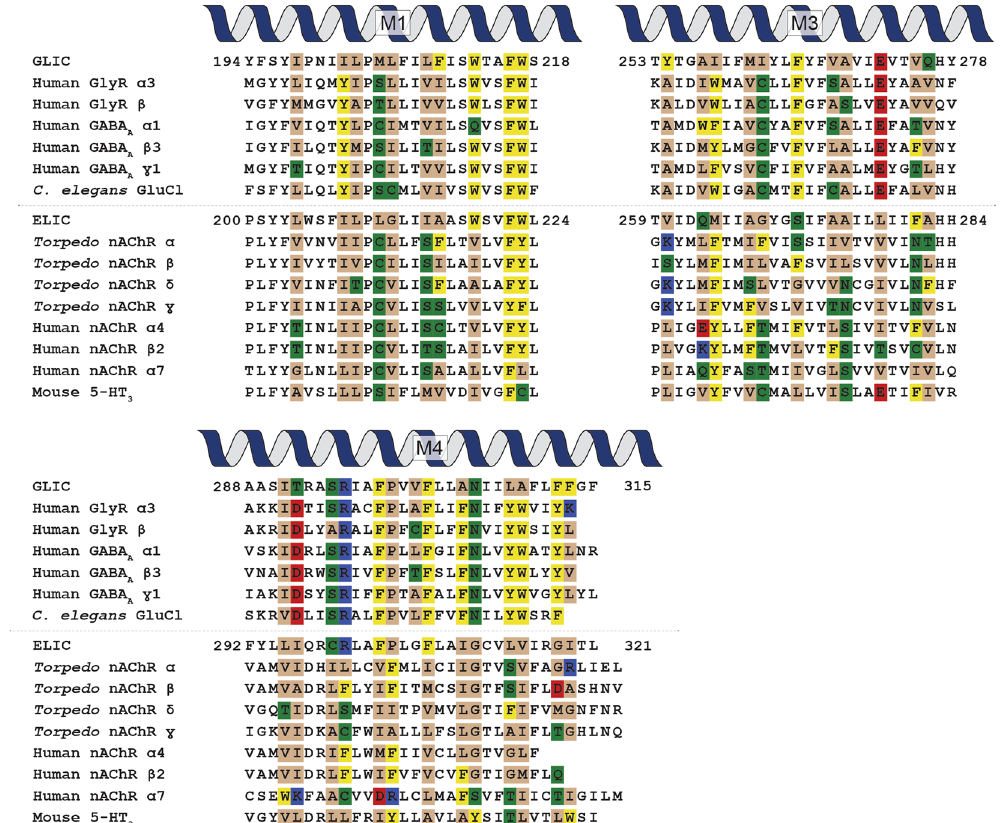
Figure 6. Sequence alignments for M1, M3 and M4 in a number of pLGICs. Residues facing the M4-M1/M3 interface are highlighted and colored depending on their properties: aromatic (yellow), hydrogen bonding (green), negatively charged (red) and positively charged